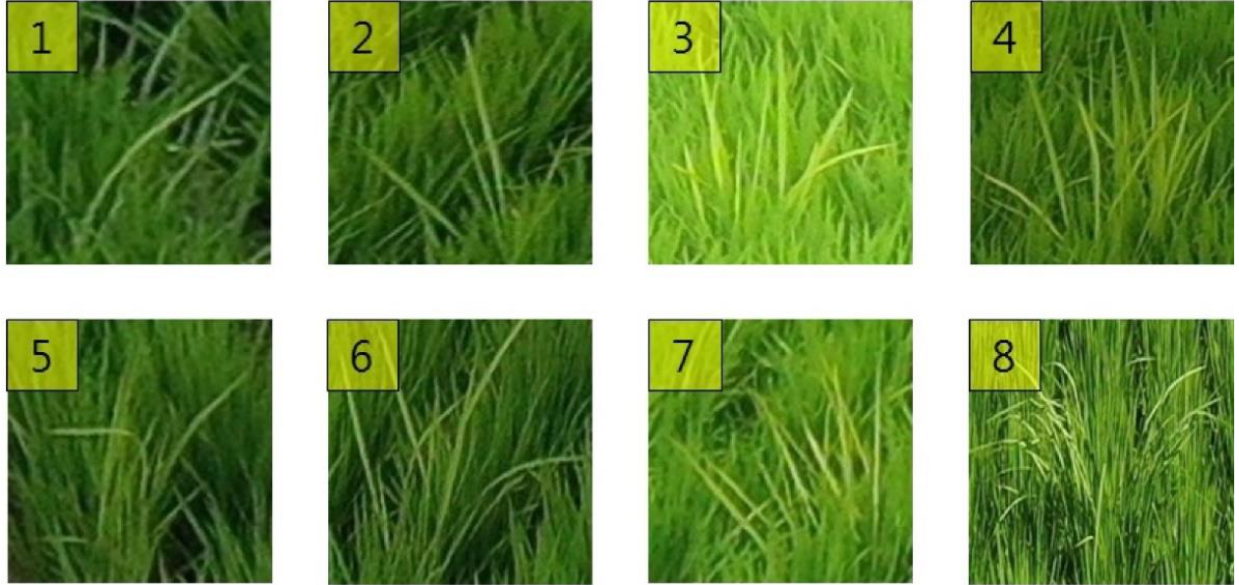
Figure 13. Random cropping procedure from original image.